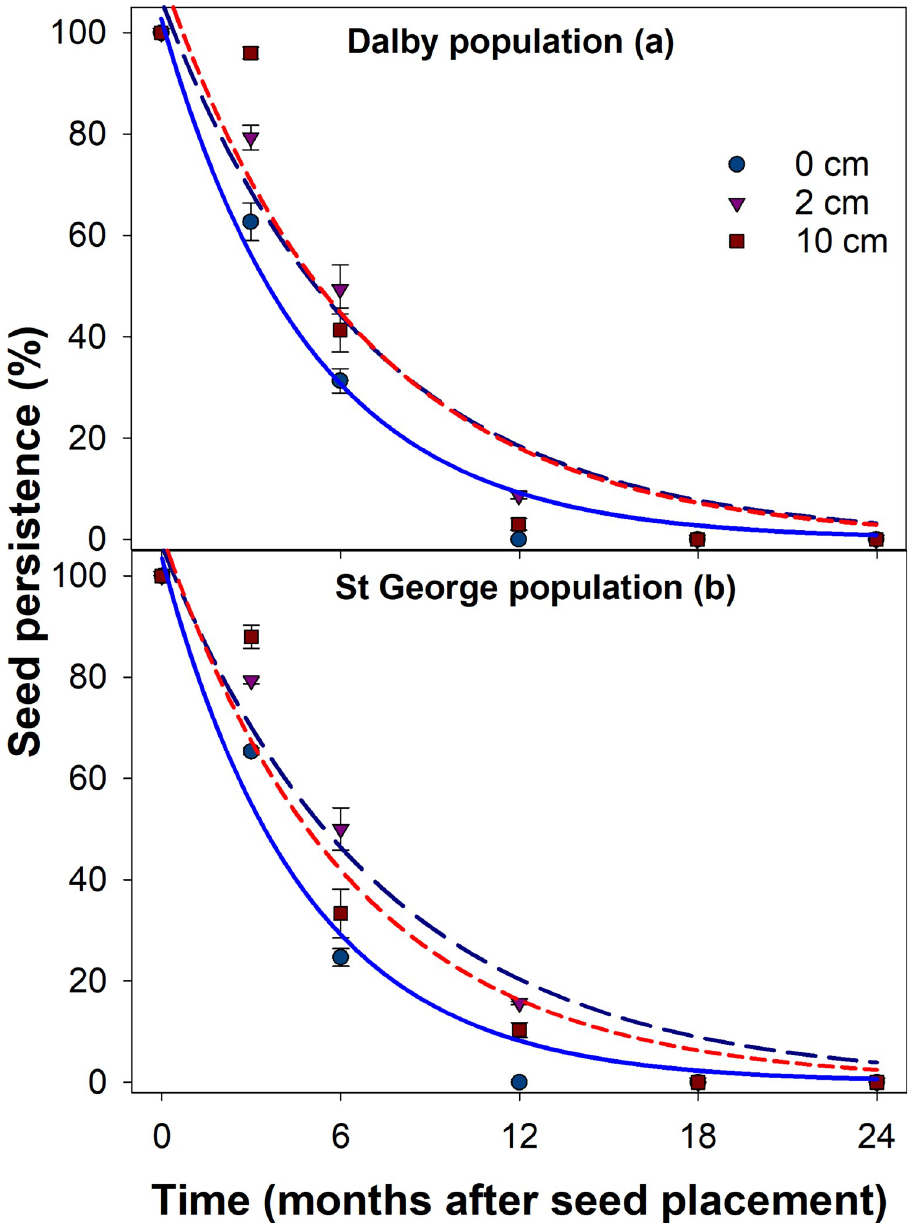
Fig 3. Effect of burial depth and burial duration on seed persistence (%) of two populations [Dalby (a) and St George (b)] of Chloris virgata . Bars are the standard error of means (n = 3). The curves represent an exponential decay model (red, 0 cm; yellow, 2 cm; and blue, 10 cm) and parameter estimates of the model are shown in Table 1. Dactyloctenium radulans There were slight differences between the Dalby and St. George populations for seed persis- tence of D . radulans ; however, both populations responded similarly to seed burial depth and duration (Fig 4; Table 1). By 2.8 (the Dalby population) and 4.4 months (the St George popula- tion), 50% of the surface seeds of D . radulans had already decayed. However, 10% of seeds were still viable at 10 months for the Dalby population and 15 months for the St George popu- lation. It took 36 months to completely deplete the surface seeds of D . radulans . Buried seeds